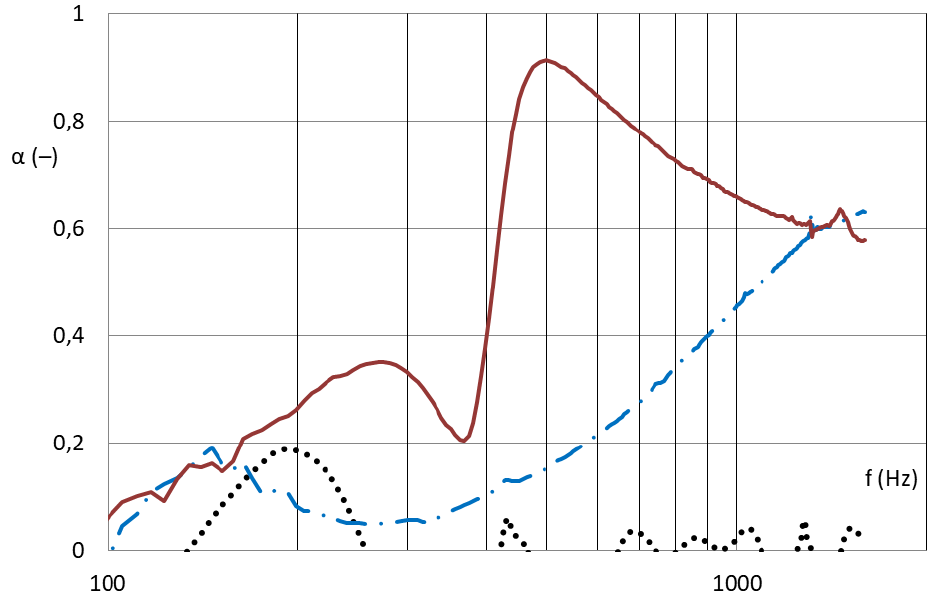
Figure 3. Frequency dependence of the sound absorption coefficient; aluminum perforated sheet with a thickness of 1 mm, with square centered holes with a hole diameter of 8 mm, hole spacing of 10 mm (black dotted line), the same perforated sheet with a nanolayer carrier (blue dashed line) and a perforated sheet with a nanolayer on a carrier (red line). All the samples were placed at a distance of 50 mm from wall [14].